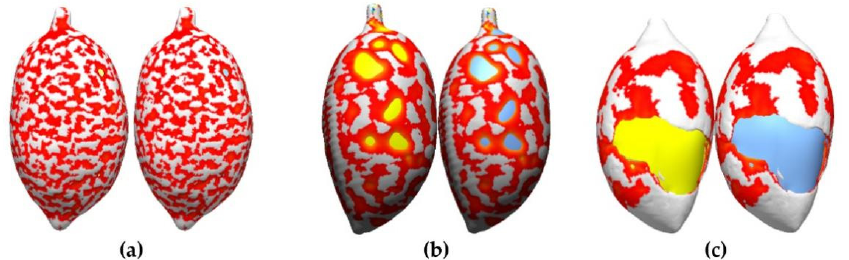
Figure 24. Damage to Picuda variety olives: ( a ) the olives with manual harvesting, ( b ) the olives with mechanical harvesting, and ( c ) the diseased olives.